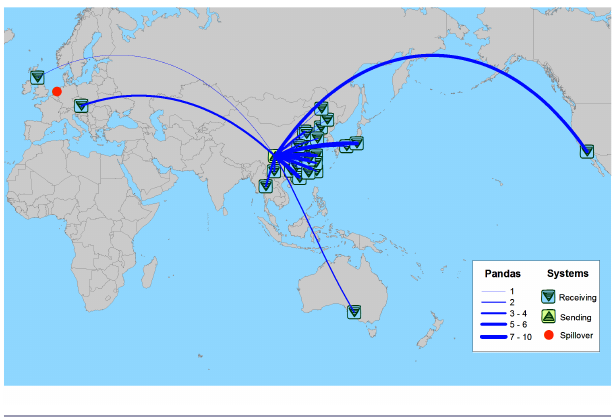
Fig. 6 . Flows of pandas across telecoupled systems. The thickness of each geodesic line is proportional to the number of units